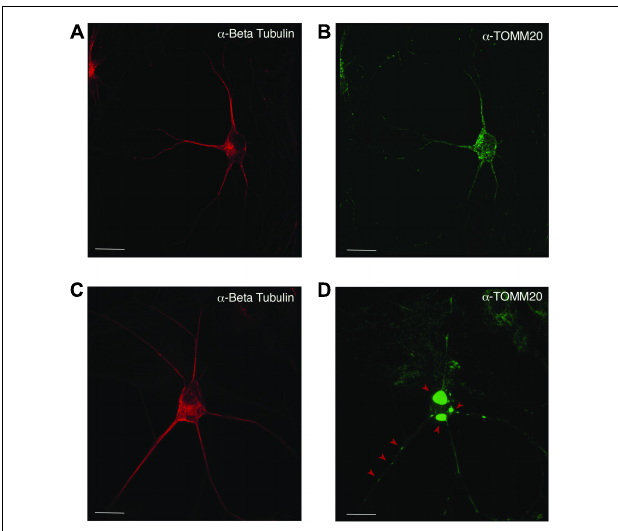
FIGURE 5 | Mislocalization and reduced dispersion of mitochondria in ASD neurons. Neuronal cultures visualized with anti-beta tubulin (red) and the mitochondrial marker anti-TOMM20 (green). The PW-UPD -ASD neuron (top row) shows bright and evenly dispersed mitochondria within the neuronal projections. In PW-UPD + ASD neuron, the red arrows point to mitochondrial aggregates not seen in the PW-UPD -ASD neurons. (A,C) show neuronal morphology using anti-beta tubulin staining. (B,D) show the anti-TOMM20 staining to identify mitochondria. Confocal stacks were taken at 63X magnification. Scale bar is 20 µ m.